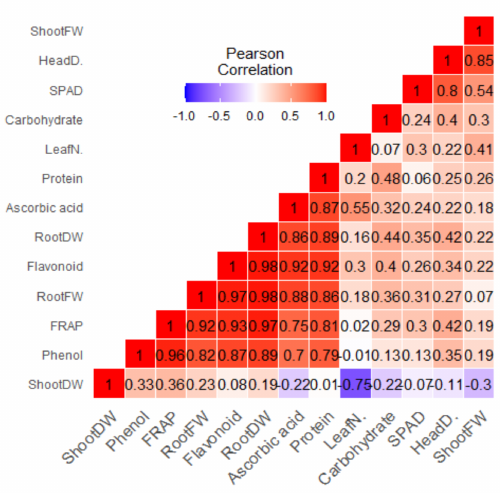
Figure 5. Heat map of Pearson’s correlation analysis for the effect of arbuscular mycorrhiza (AMF) inoculation and seaweed extract (SWE) foliar spray on lettuce. Heat map representing head DW (dry weight), root FW (fresh weight), flavonoid (total flavonoids content), root DW, protein (total proteins content), TAA (total antioxidants activity by FRAP method), phenol (total phenolics content), carbohydrate content, head D (head diameter), head FW, SPAD (chlorophyll index), and leaf N (leaf number).